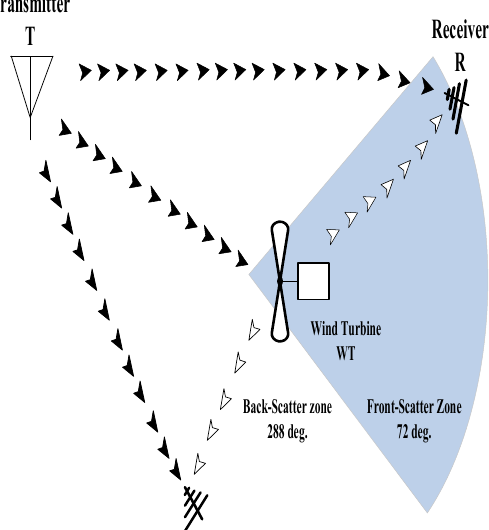
Figure 5. Visualization of the propose relative position of the transmitter, receiver and a wind tur- bine that may generate EMI